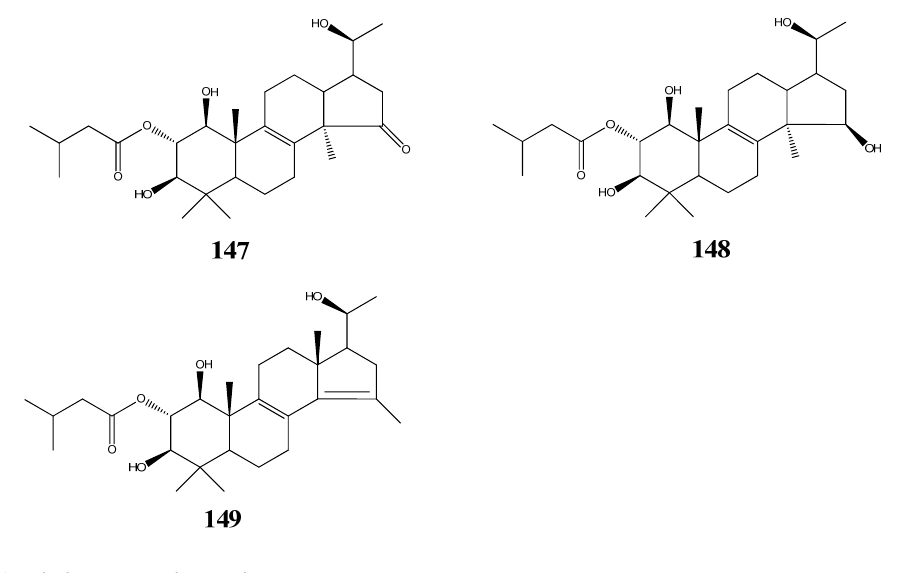
Figure 20. Triterpenoids xylariacins A-C from marine-derived